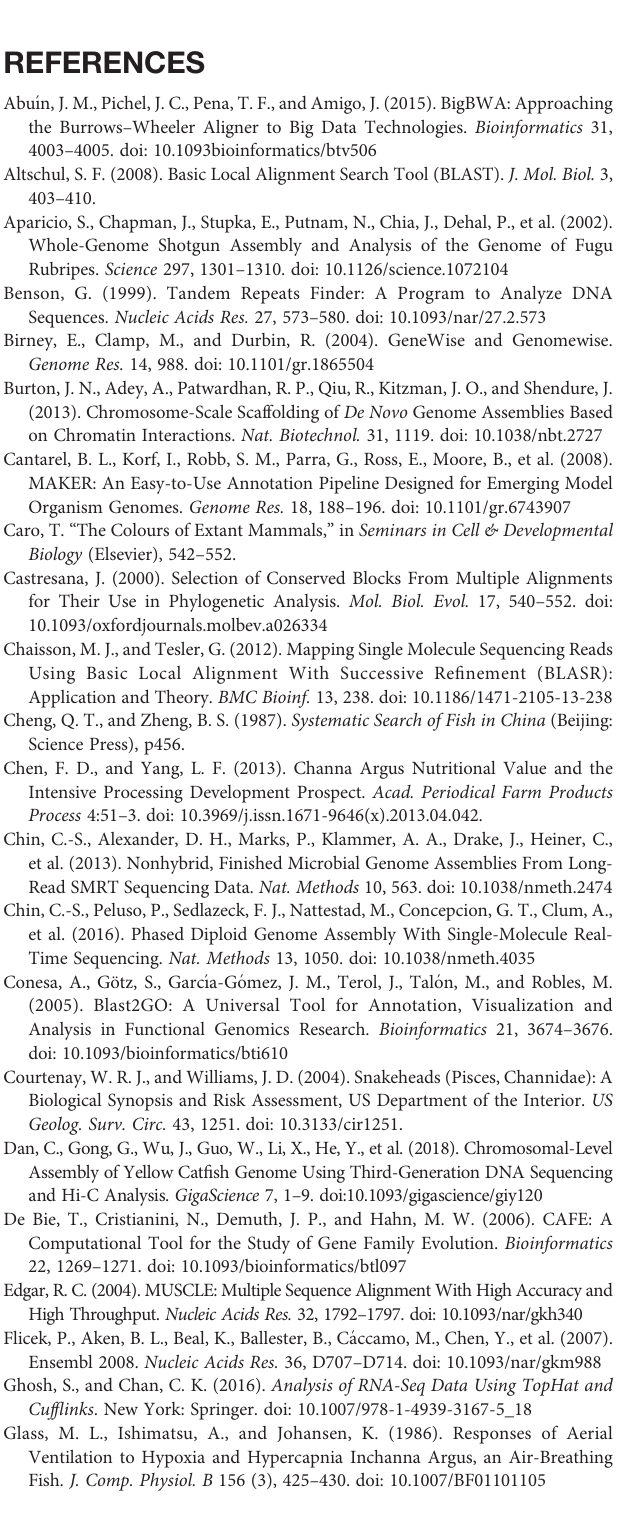
Supplementary Figure 4 | The number of expanded and contracted gene families deduced using cafe for each branch. Supplementary Figure 5 | The genome landscape for the C. argus var. From the outside to inside was GC content (pink), chromosome, gene density by